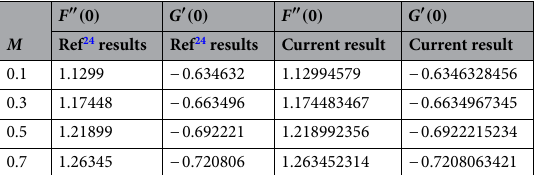
Table 4. Comparison between the present results and Ref for the velocity gradient at different values of Re for φ